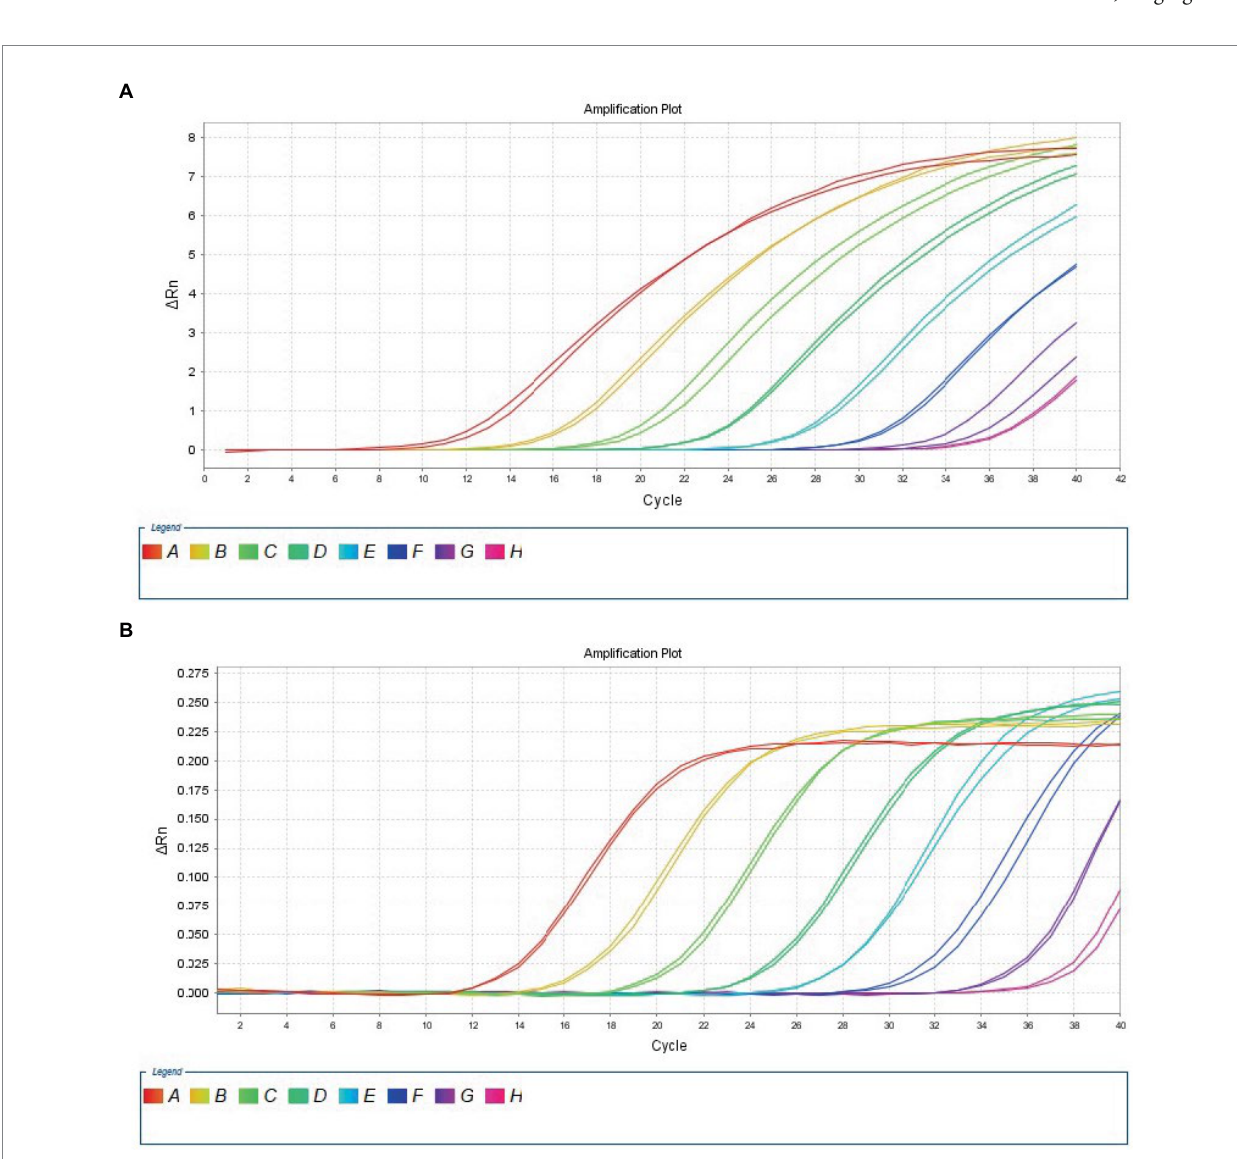
FIGURE 2 Sensitivity analysis of duplex TaqMan qPCR method for detection of Tembusu virus (A) and goose astrovirus (B) in unmixed positive standard control. A to H represents standard template at 1.0 × 10 8 –1.0 × 10 1 copies/ μ